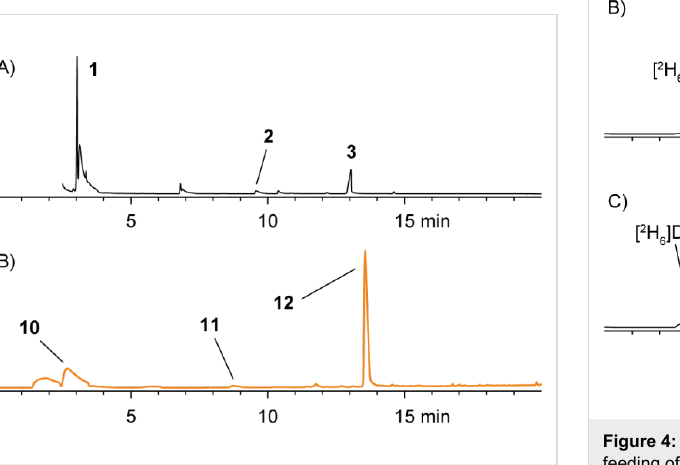
Figure 3: Chromatograms of headspace extracts from P. gallaeciensis DSM 17395 after feeding of DMTeP by the use of (A) CLSA (black) and (B) SPME (orange).